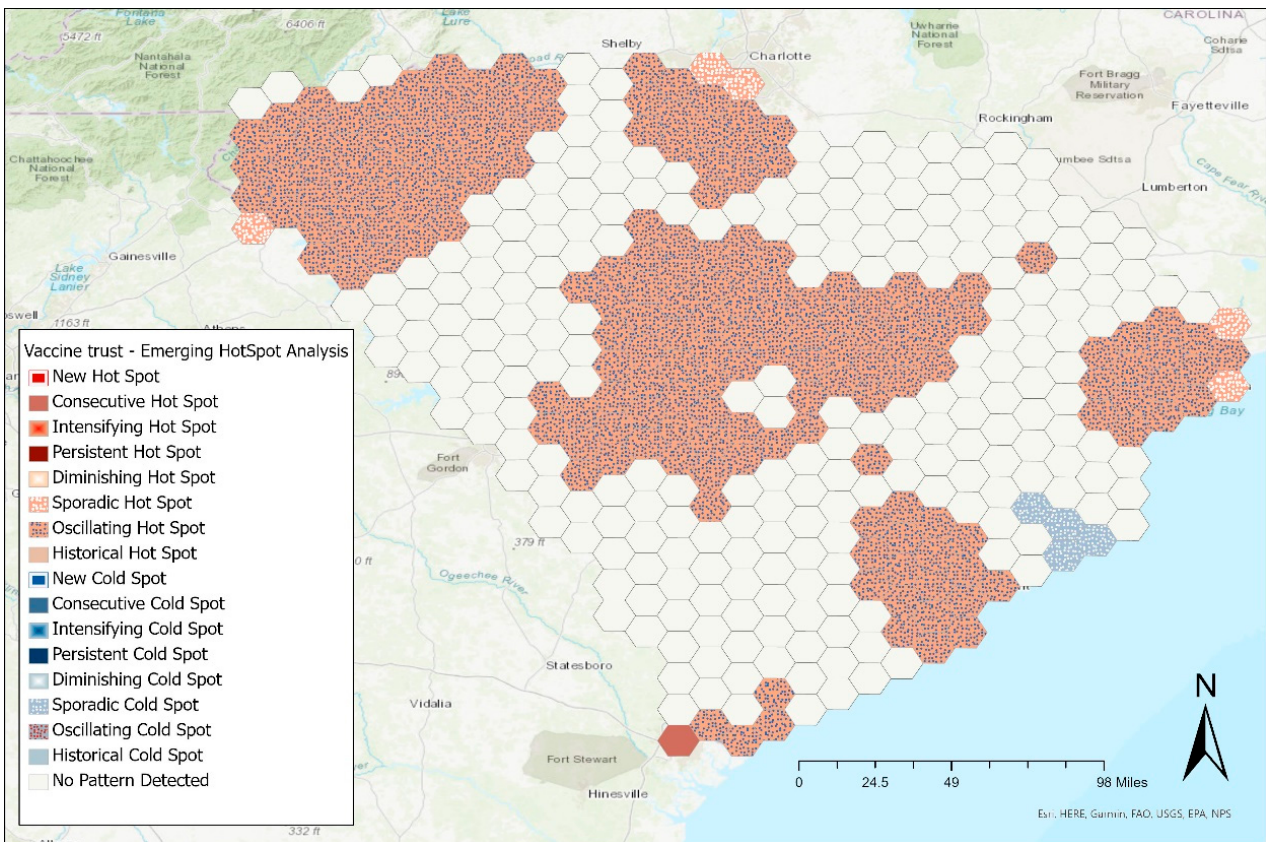
Figure 6. Emerging hotspot analysis of COVID-19 vaccine perception among South Carolina residents, between January 2021 and October 2021.